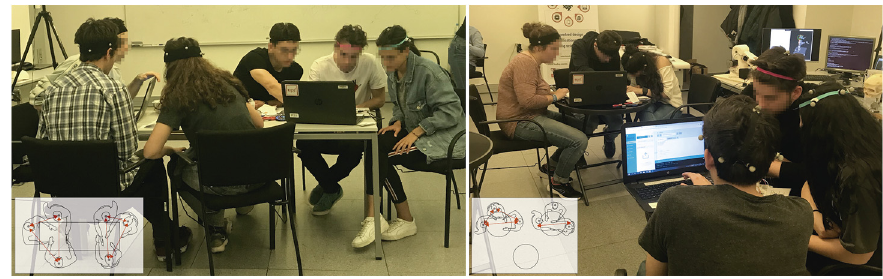
Figure 1. Two seating arrangements representing different conditions in the study.